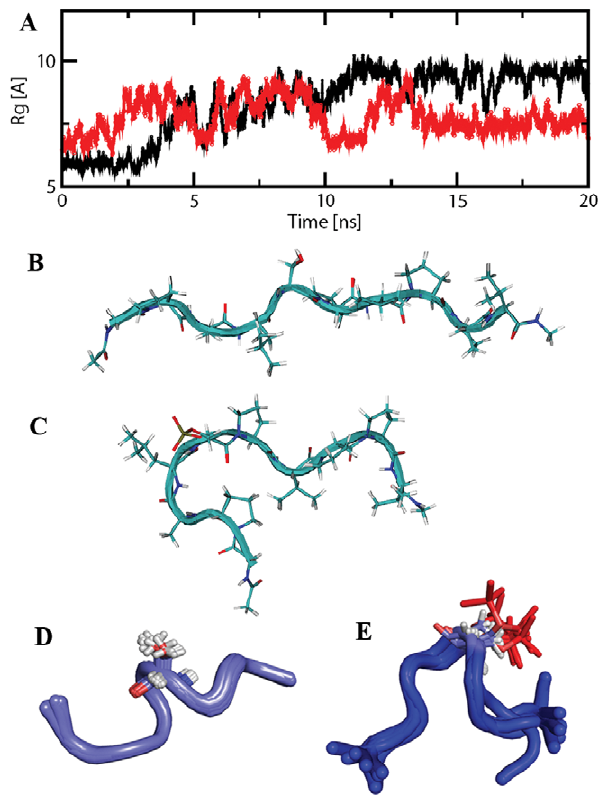
Figure 2. Conformational change of S87 after phosphorylation. (A) Trajectories of radius of gyration (Rg) for peptide S87 in an unphosphorylated (black line) and a phosphorylated (red line) state. (B) Representative structure of the largest-member cluster of unpho- sphorylated S87 peptide from the final 5 ns simulation trajectory. (C) Representative structure of the largest-member cluster (84%) of phosphorylated S87 peptide from the final 5 ns simulation trajectory. (D) NMR structure ensemble of the 10 lowest energy structures for S87 peptide. (E) NMR structure ensemble of the 10 lowest energy structures for pS87 peptide. Serine and phosphoserine groups are highlighted with sticks.